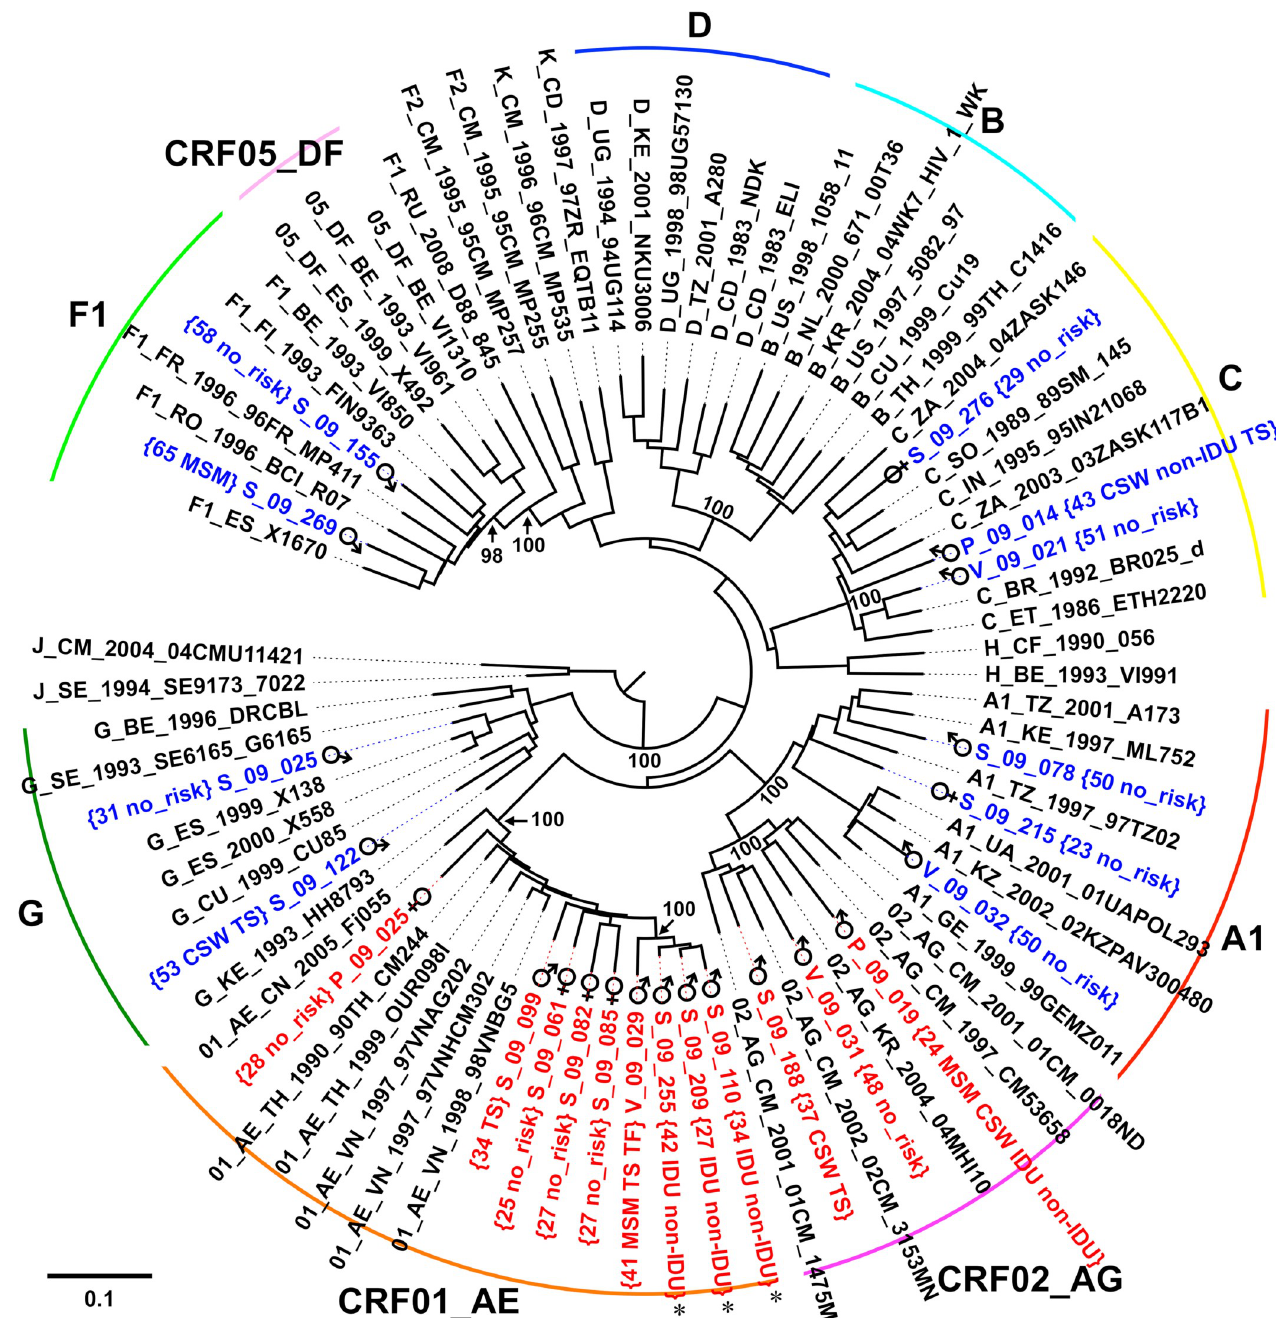
Fig 3. Phylogenetic tree of HIV-1 env sequences from Bulgaria. Neighbor-joining tree of env gene sequences denoted with group subtypes, participant age at enrollment, gender, and self-identified risk factors. Study participant strains from pure subtypes are shown in blue and recombinant strains are shown in red. The trio of males with intra-group genetic distances less than 3% are marked with � . Bootstrap values at relevant nodes are shown. The scale bar indicates a genetic distance of 10%.